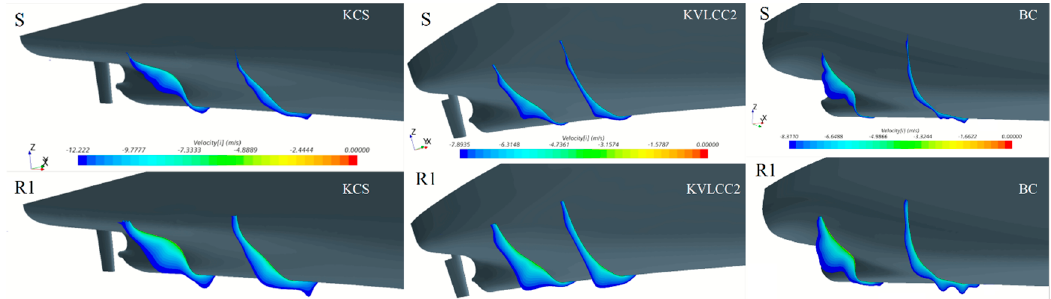
Figure 17. The obtained boundary layers for smooth ships ( upper ) and fouled ships with fouling condition R1 ( lower ).